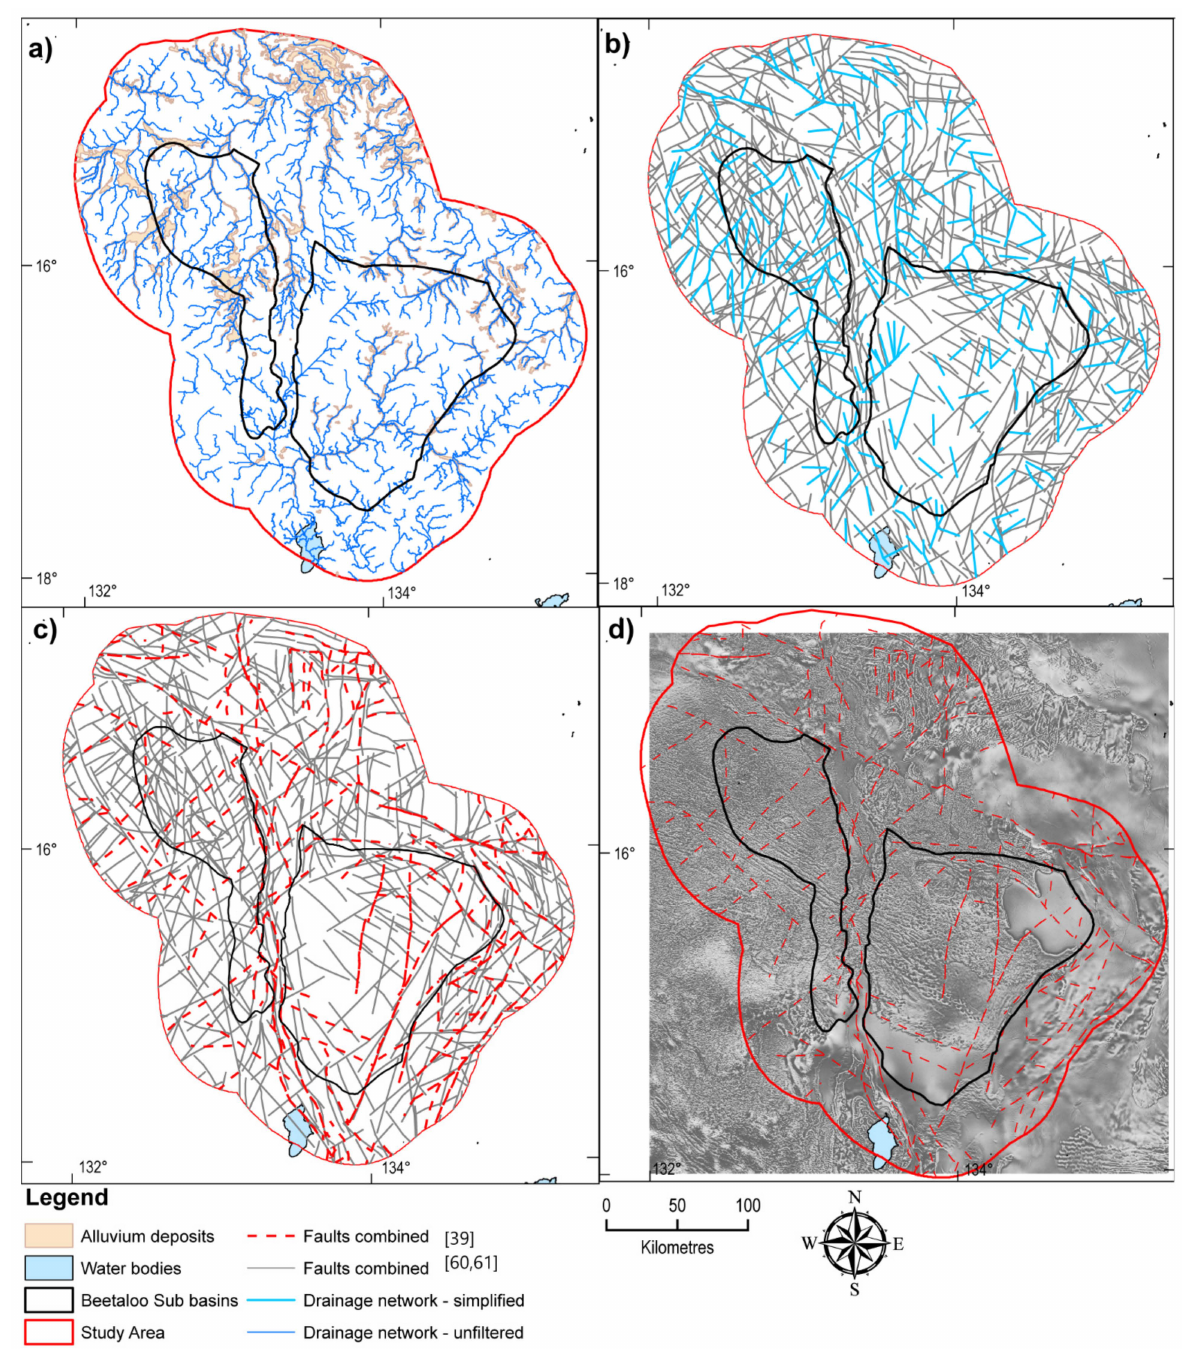
Figure 2. Unfiltered surface drainage network ( a ) and simplified interpretation ( b ) within the con- text of fault lineament datasets ( c ) and magnetic image of the first vertical derivative (( d )-details in Section 4.1) where lineaments were identified Simplified drainage network adopted approach: small segments with less than 10 nodes were automatically removed in SKUA (Paradigm/Emerson Trademark) and one iteration of smoothing was applied that further removed small irregularities without changing the overall orientation of major drainage lines. This output was then overlayed upon satellite and magnetic images where lineaments are evident for checking and quality con- trol. In this process, minor mismatches of the automated simplified lines were removed and small drainage segments were connected along major lineaments for further simplification and reduction of the